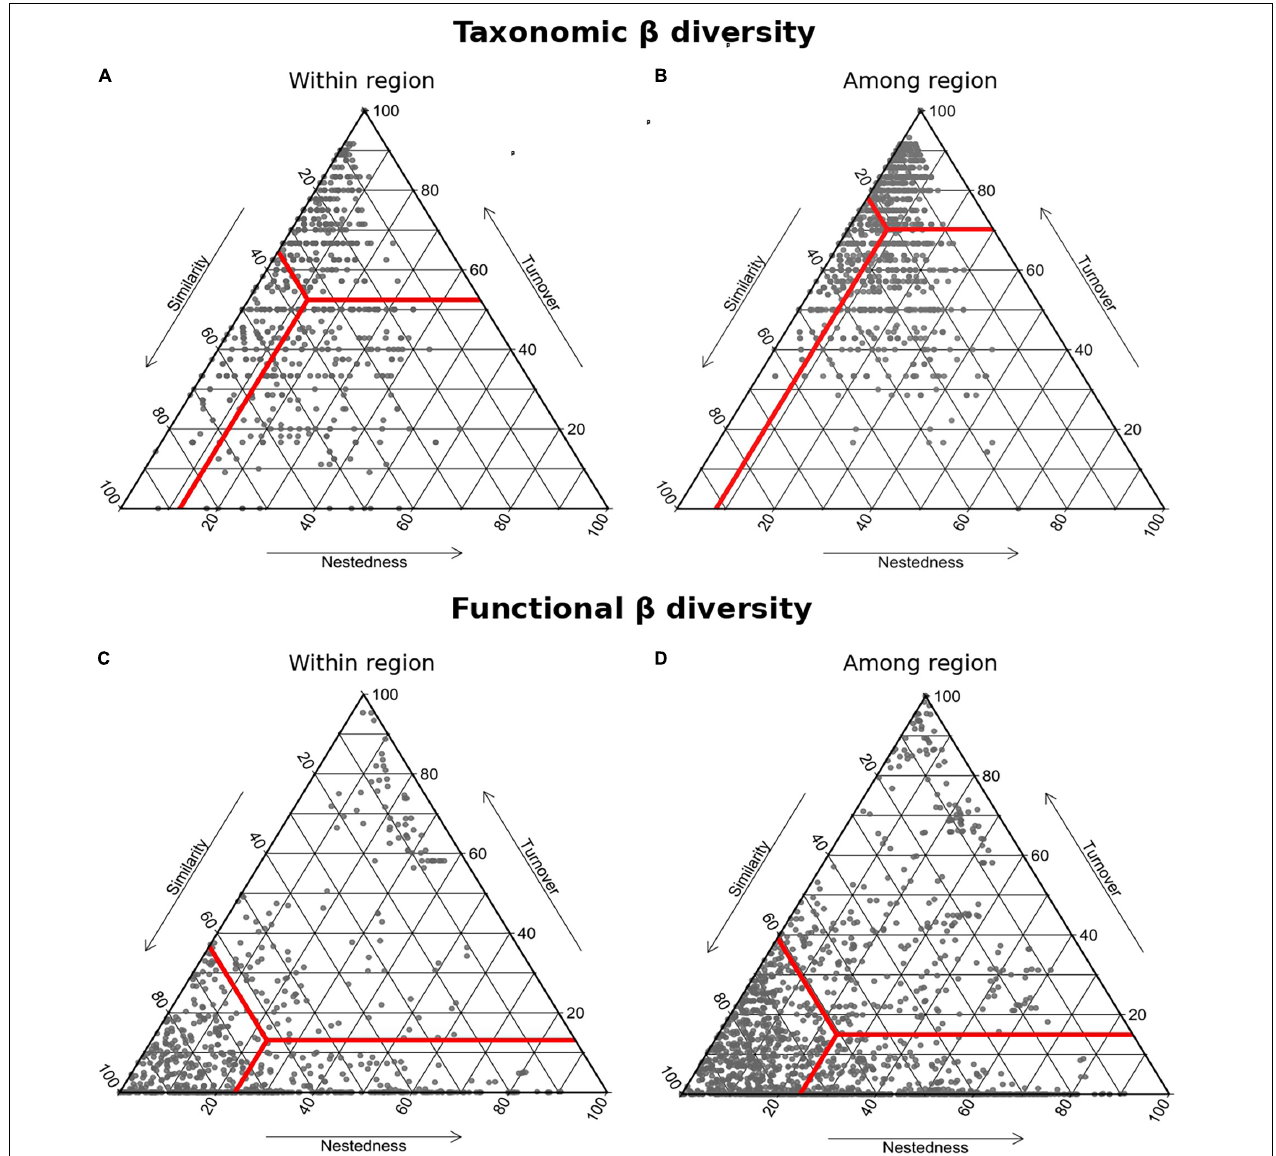
FIGURE 5 | Triangular plots illustrating the geographical pattern of (A,B) taxonomic and (C,D) functional β diversity Sorensen dissimilarity between the species composition (presence/absence data) of the 10 study sites was used to quantify their similarity, and the two components of their beta diversity nestedness (i.e., influenced by the difference in number of species between the two communities) and turnover (i.e., species replacement between two communities). Contributions were calculated for comparisons between samples belonging either to (A,C) the same bioregion (within bioregion) or to (B,D) different bioregions (among bioregion). Red lines indicate the centroid value for each graph with its associated mean values for the three components of the Sorensen